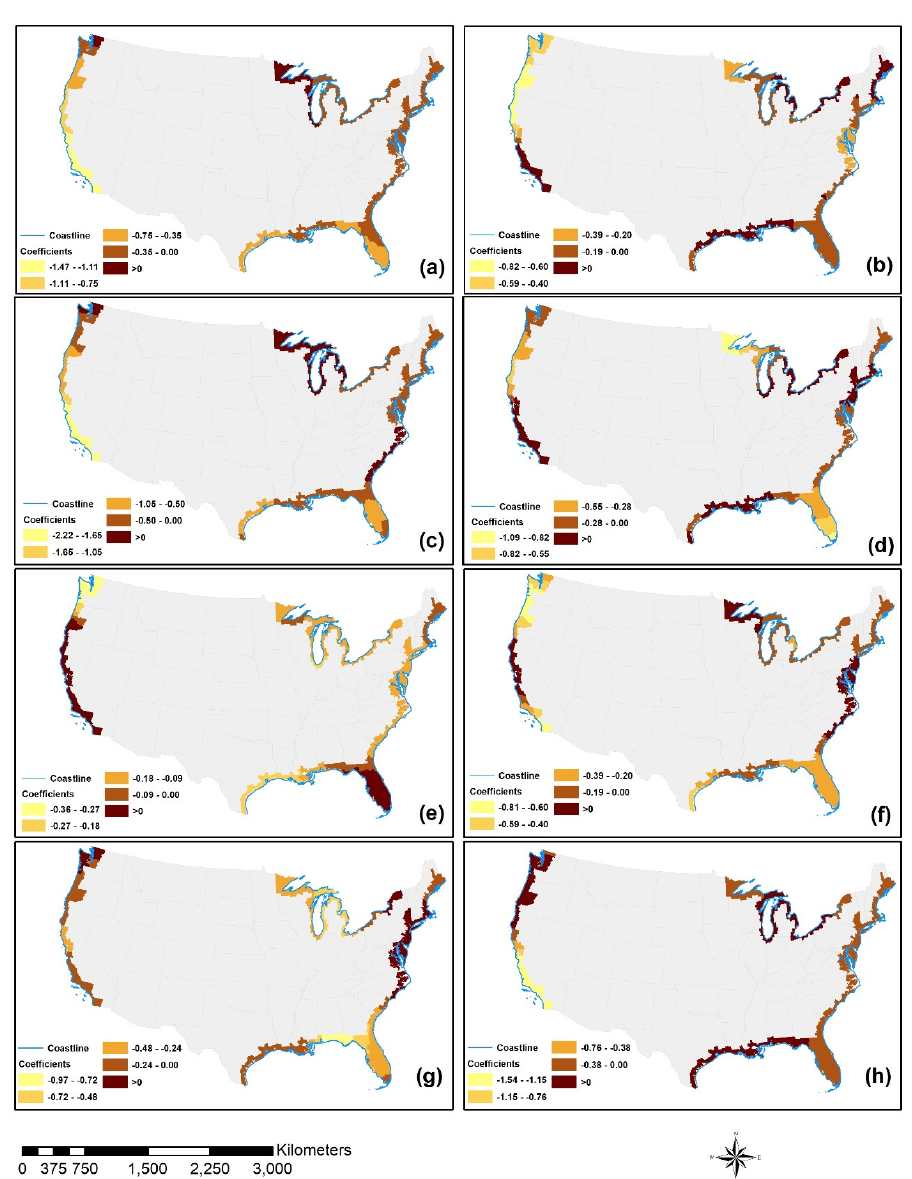
Figure 5. The spatial distribution of coefficients of the eight community resilience components in the GWR model: ( a ) community capital-environmental-infrastructural; ( b ) social-infrastructural; ( c ) social-environmental; ( d ) economic-community involvement; ( e ) housing-economic; ( f ) environmental-social; ( g ) environmental-community involvement; and ( h ) community capital- environmental.